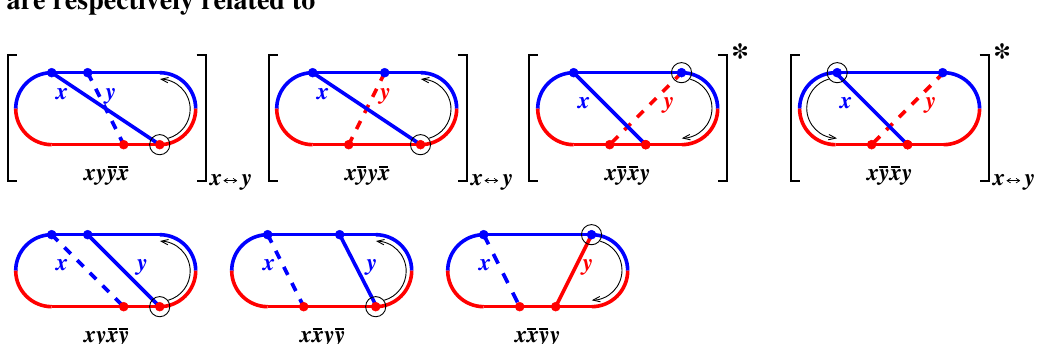
Figure 9 . Relation of all but one Class I virtual diagram ((cid:12)gure 4) to real g The black arrows indicate moving the latest-time (or earliest-time) vertex using a back-end (or front-end) transformation